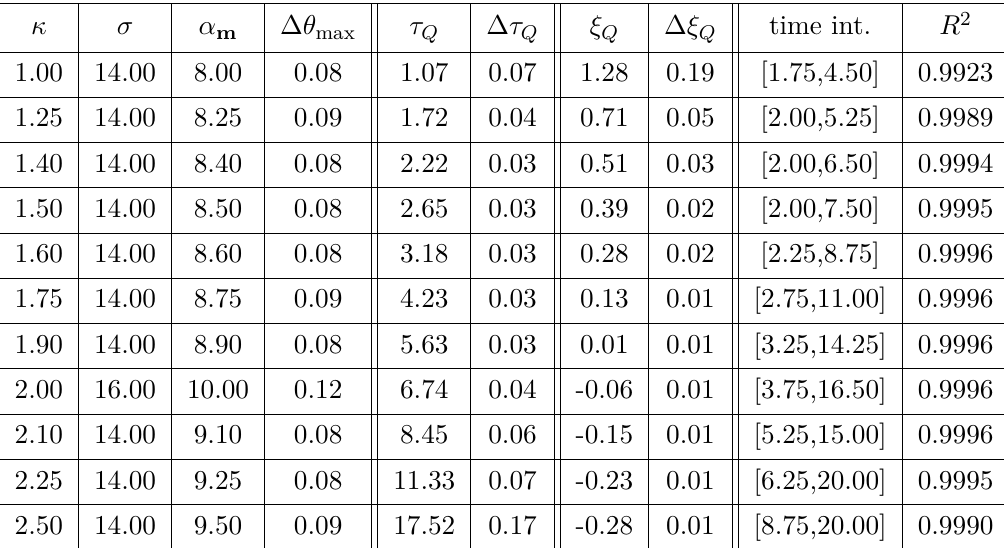
+ ξ for various κ and T = 0 . The fitting Q a τ Q indicates the best max ∆ τ and ξ ∆ ξ correspond to the 95% -confidence bounds of the Q ± Q Q ± Q are fitted as displayed in figure 8 with fit parameters shown in Q